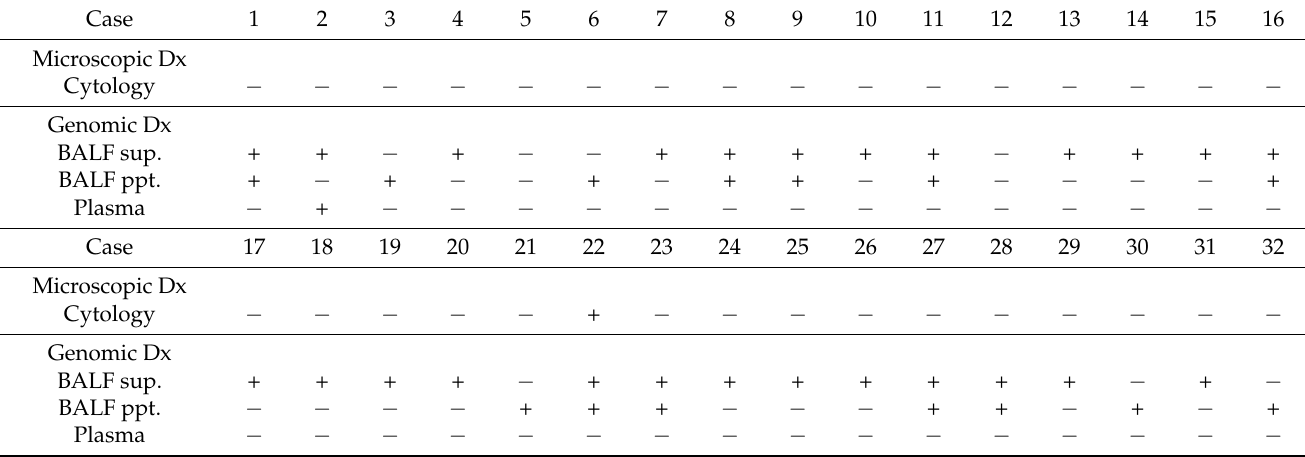
Table 2. Conventional and genomic bronchoscopic diagnoses of lung cancer.